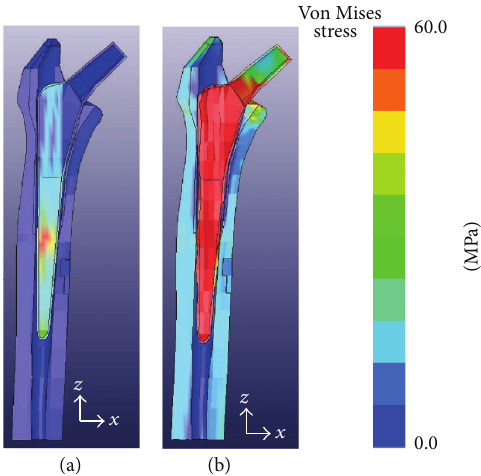
Figure 4: Von Mises stress distribution analyzed by finite element methods. (a) Two weeks. (b) Five